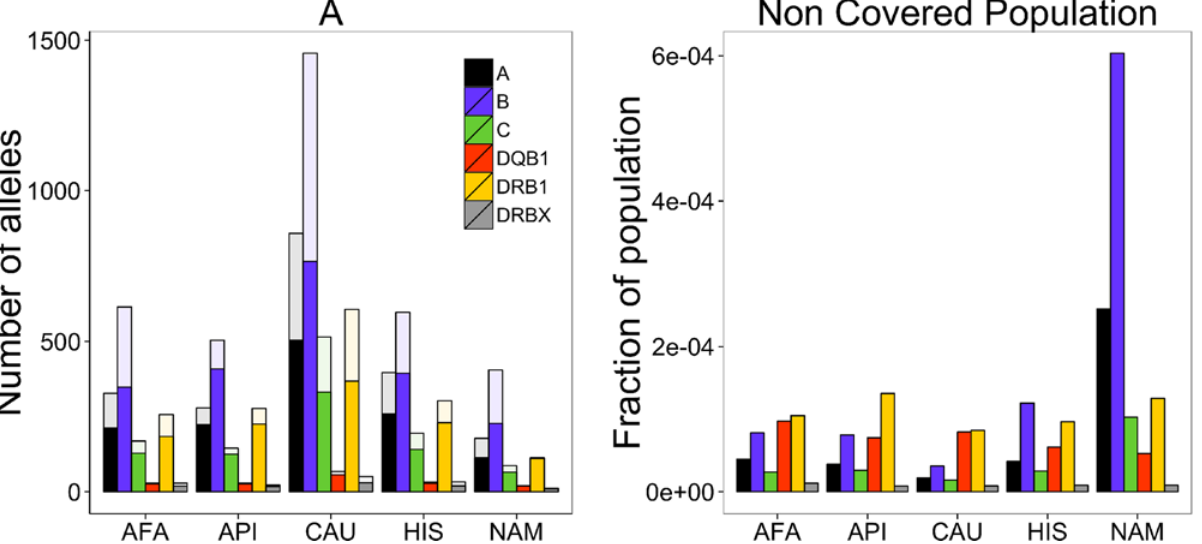
Fig 6. Alleles results. (left) Known (colored) vs. total alleles (transparent) for the five combined populations. The fraction of known alleles is between 50 and 100%. (right) Fraction of uncovered population per allele and combined population. These fractions are much lower than for haplotypes and never reach more than